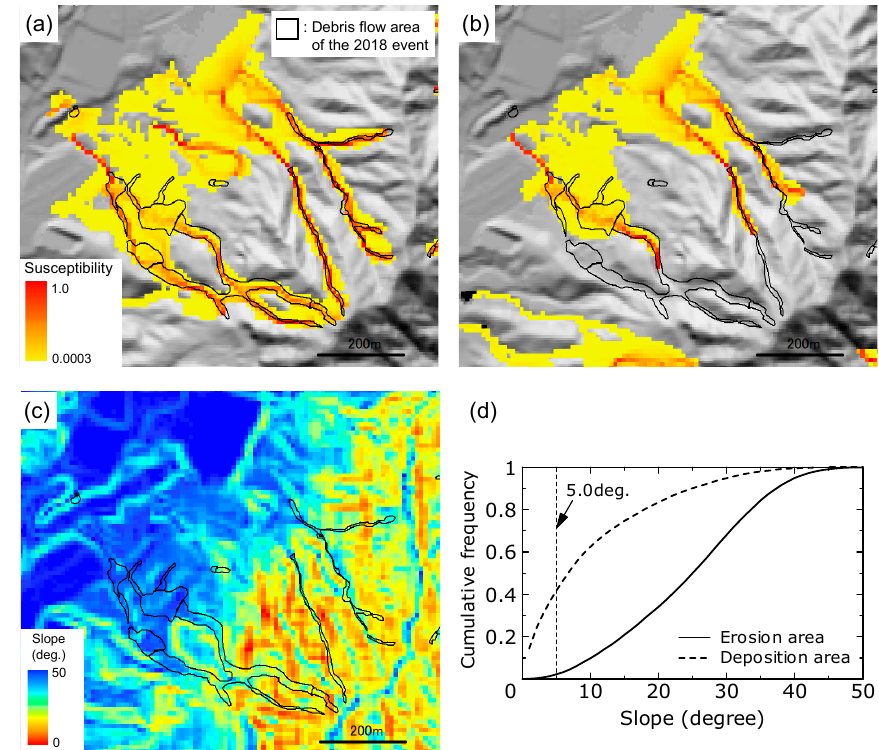
Figure 9. ( a ) Debris flow propagation areas by Flow-R analysis using manually identified sources. ( b ) Debris flow propagation areas using automatically identified sources based on criteria for extreme event. ( c ) Slope gradients with debris flow areas. ( d ) Cumulative frequency of slopes in erosion and deposition areas.